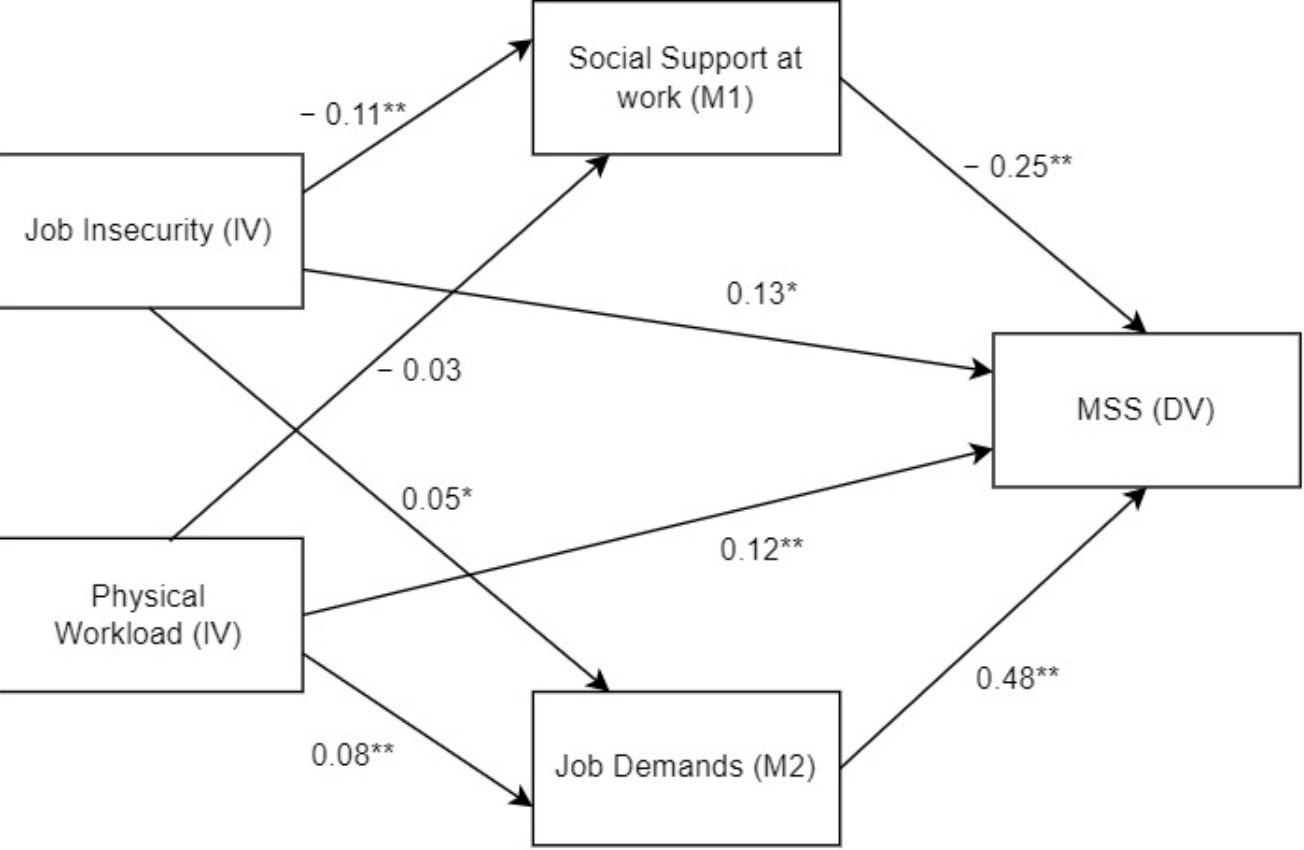
Figure 2 . Resulting parallel mediation model . * p < 0.05, ** p < 0.01 Figure 2. Resulting parallel mediation model. * p < 0.05, ** p <